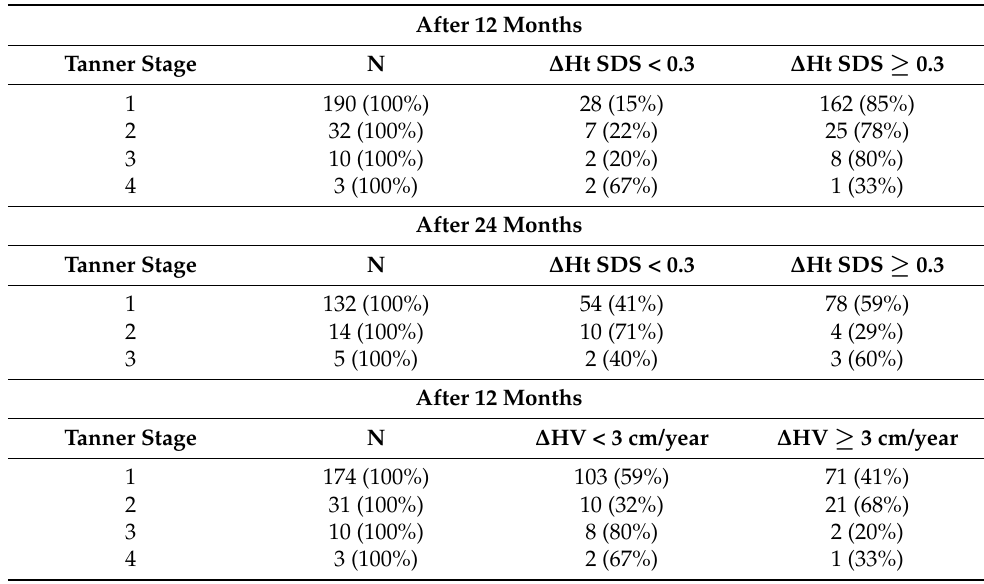
Table 4. Response to treatment according to pubertal